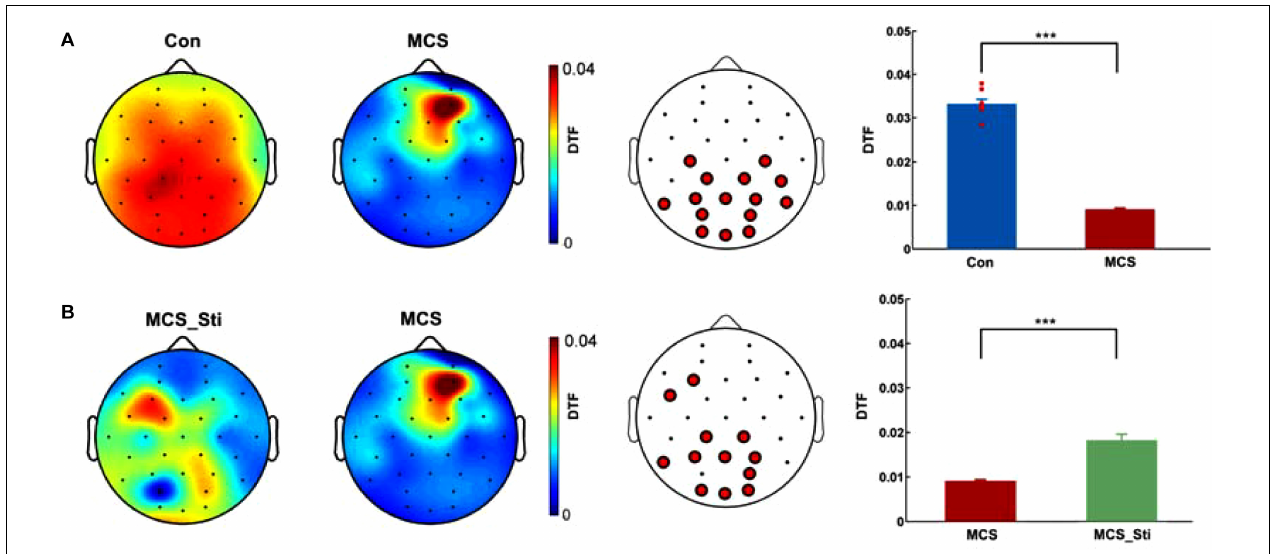
FIGURE 1 | Comparison of DTF values in the gamma frequency of EEGs between controls and patient 1 (MCS) before and after stimulation treatment. (A) DTF spatial distribution in healthy controls (Con) and patient 1 (MCS). The color bar denotes the DTF values. First panel: eight healthy controls. Second panel: compared to the eight healthy controls, the MCS patient showed a significantly decreased DTF value in the gamma frequency in bilateral posterior regions. Third panel: 15 electrodes with significantly reduced DTF values in patient 1 compared to those in healthy controls were identified. Fourth panel: the average DTF value of the 15 electrodes was significantly lower in the MCS patient than in Con ( ∗∗∗ p < 0.001, t -test/Wilcoxon’s rank sum test). The blue bar denotes the DTF value of the 15 electrodes in eight controls. The red bar denotes the pretreatment DTF value of the 15 electrodes in the patient. The DTF value (averaged across channels) of each single healthy control is shown as a dot. (B) Spatial distribution of the DTF value in patient 1 before and after treatment. First panel: the MCS patient after stimulation treatment showed a significant increase in the DTF value in the gamma frequency in bilateral posterior regions. Second panel: the MCS patient before treatment. Third panel: 12 electrodes with significantly higher DTF values after treatment compared to those before treatment were identified ( ∗∗∗ p < 0.001). The red bar denotes the pretreatment DTF value of the 12 electrodes in the patient. The green bar denotes the post-treatment DTF value of the 12 electrodes in the patient. DTF, directional transfer function; EEG, electroencephalography; Con, controls; MCS, minimally conscious state; MCS_Sti, minimally conscious state after